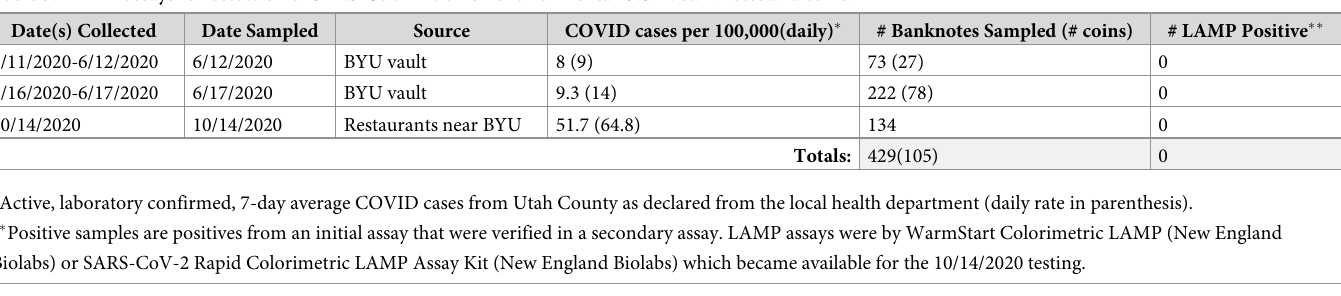
Table 3. LAMP assays for detection of SARS-CoV-2 RNA on environmental U.S.A. banknotes and